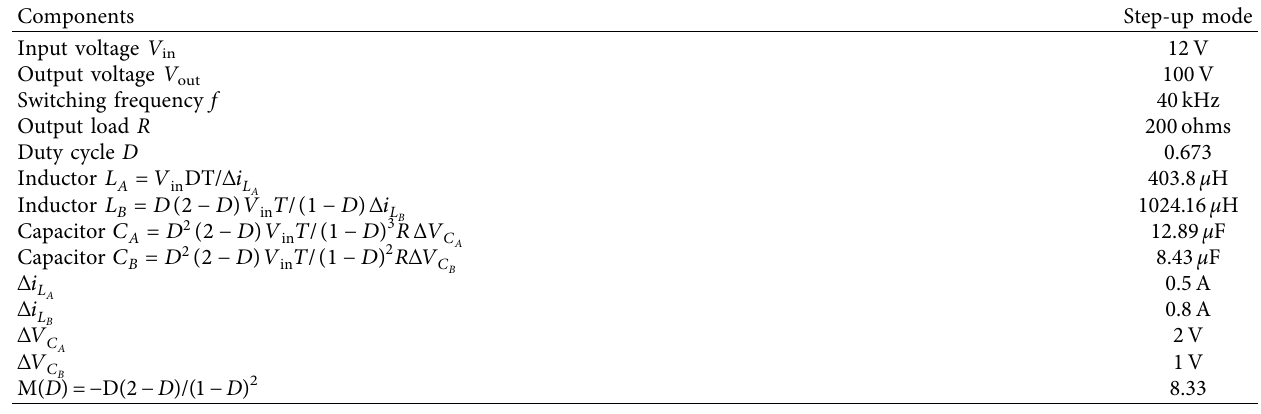
Table 2: Parameters of main components.